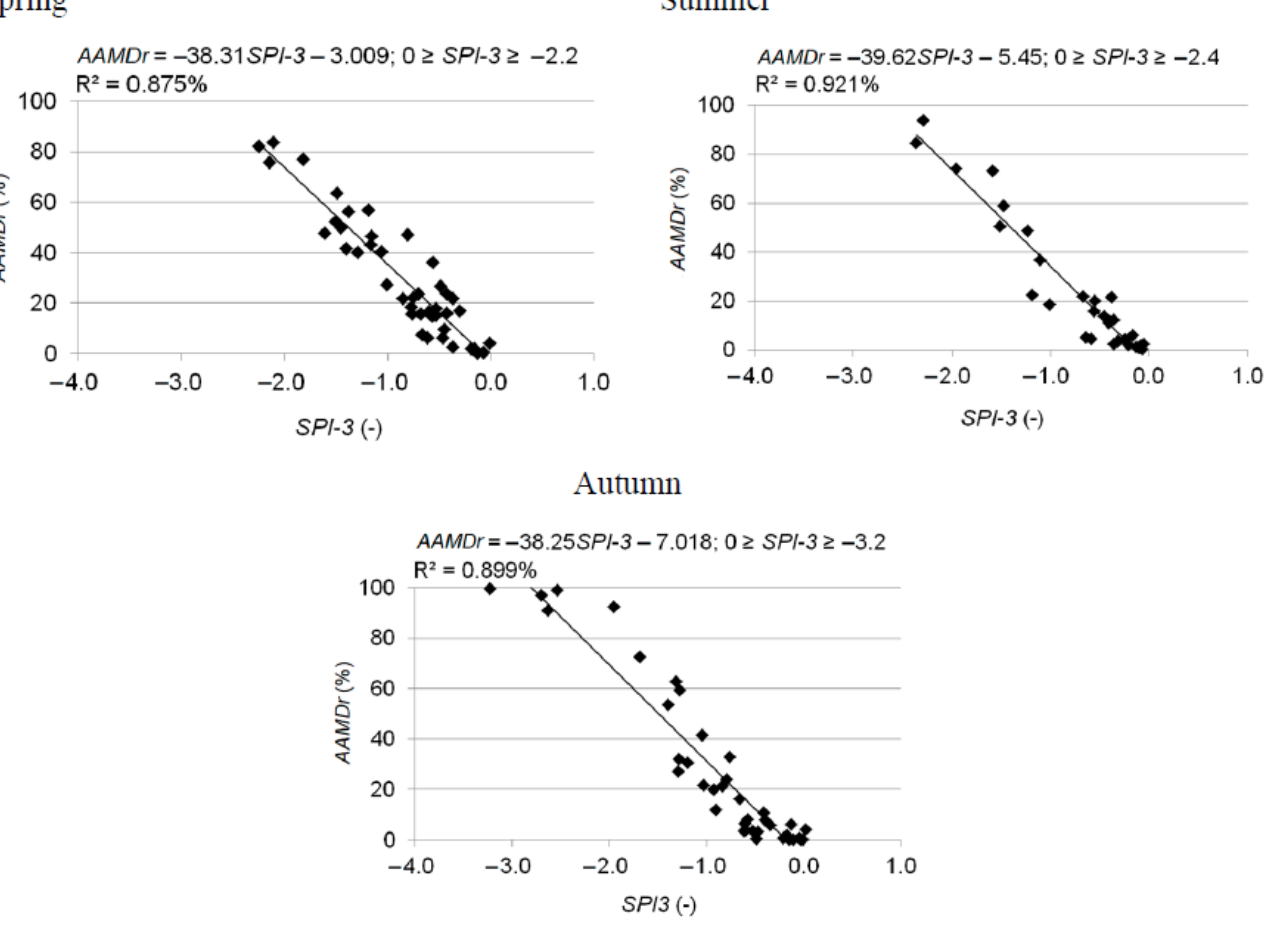
Figure 9. Dependence on SPI-3 of Poland’s area affected by meteorological drought ( AAMDr ), ranging from the minimum value to 0 in spring, summer and autumn. Years 1951–2020. Table 3. Dependence on SPI-3 of Poland’s area affected by meteorological drought ( AAMDr ) in its selected ranges in spring, summer and autumn. Years